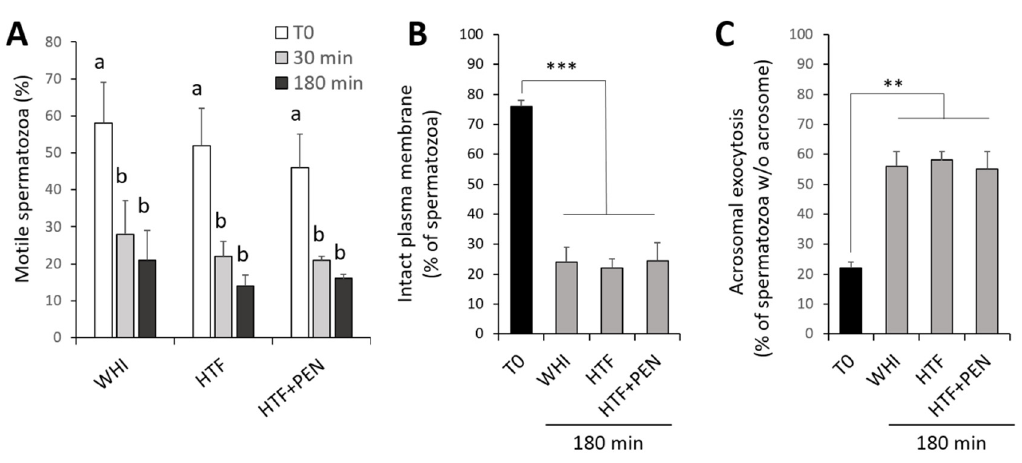
Figure 1. Sperm integrity over a 180 min period of capacitation. ( A ) Percentage of motile spermatozoa. ( B ) Percentage of spermatozoa with an intact plasma membrane as confirmed by propidium iodide staining. ( C ) Percentage of spermatozoa showing acrosomal exocytosis as determined by Arachis hypogaea (peanut) lectin conjugated with fluorescein isothiocyanate (PNA-FITC) staining. Spermatozoa after density gradient centrifugation (T0) and incubation for 30 or 180 min under capacitating conditions in three media: Whitten’s medium (WHI), synthetic human tubal fluid (HTF), and HTF supplemented with 750 µM of penicillamine (HTF + PEN). *** p < 0.0001, ** p < 0.0019; a,b different letters indicate significant differences ( p < 0.05), ( n = 6, 12 determinations).